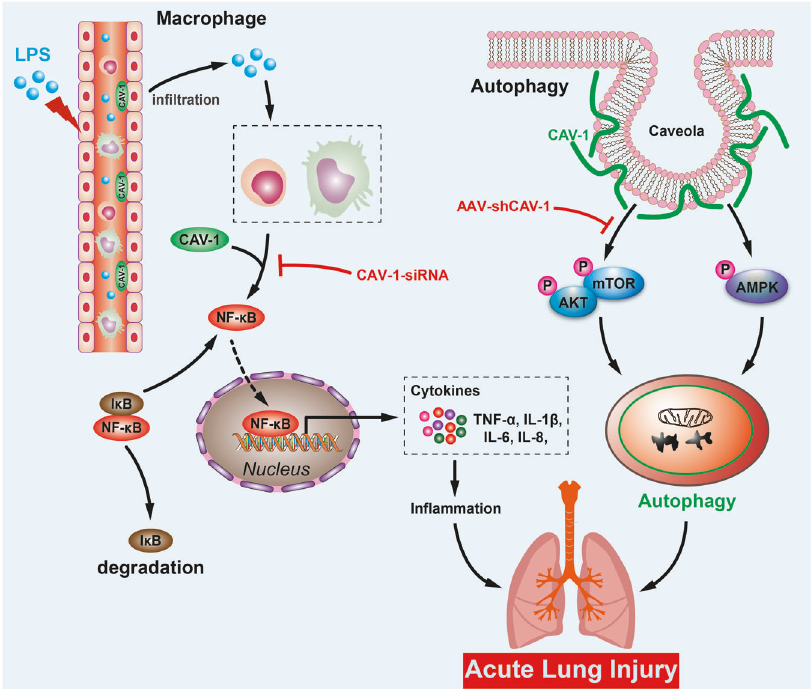
Fig. 8 Molecular mechanism of CAV-1-mediated LPS-induced ALI development. CAV-1 expression is upregulated in LPS-induced ALI, which recruits CD3 + T lymphocytes and F4/80 + macrophages to lung tissue, thereby triggering in fl ammatory response. Meanwhile, upregulated CAV- 1 could promote AKT/mTOR and inhibit AMPK to downregulate autophagy, resulting in ALI. Conversely, knockdown of CAV-1 ameliorates